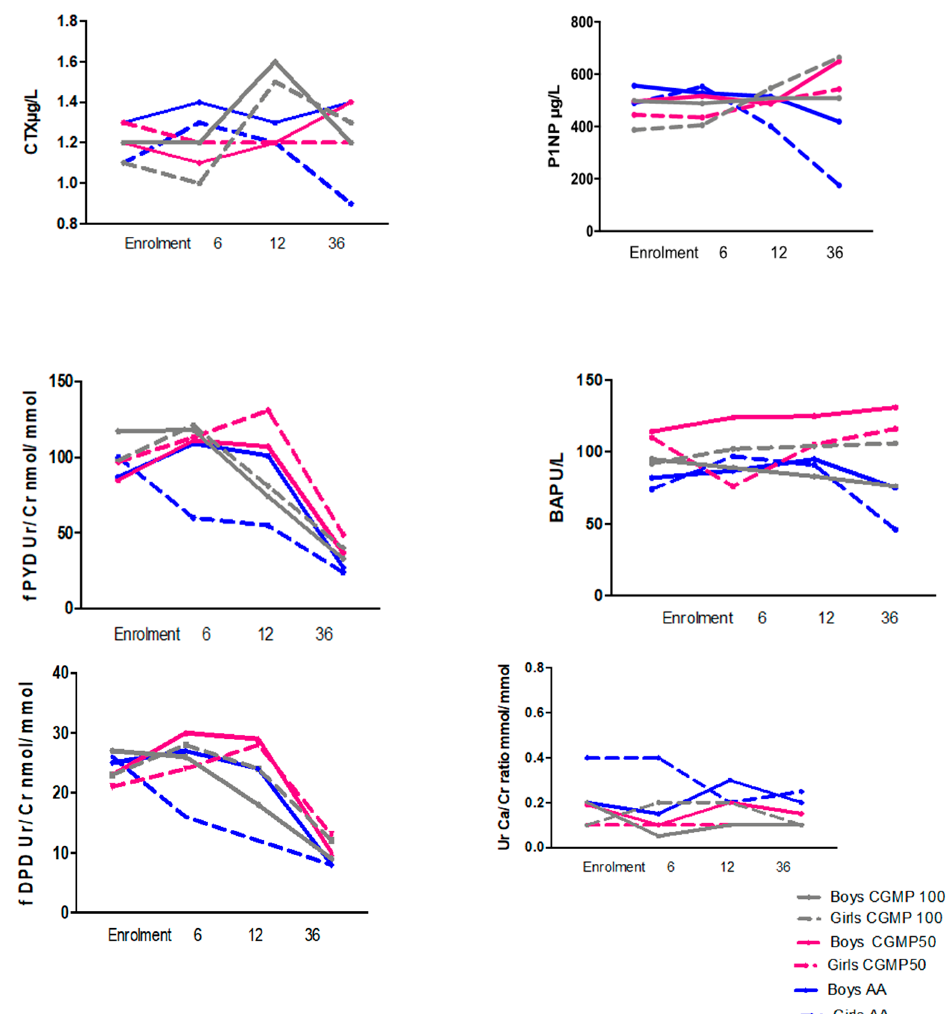
Figure 3. Graphs showing serum and urine bone turnover markers at enrolment, 6, 12, and 36 months separated by gender for CGMP100, CGMP50, and L-AA groups.